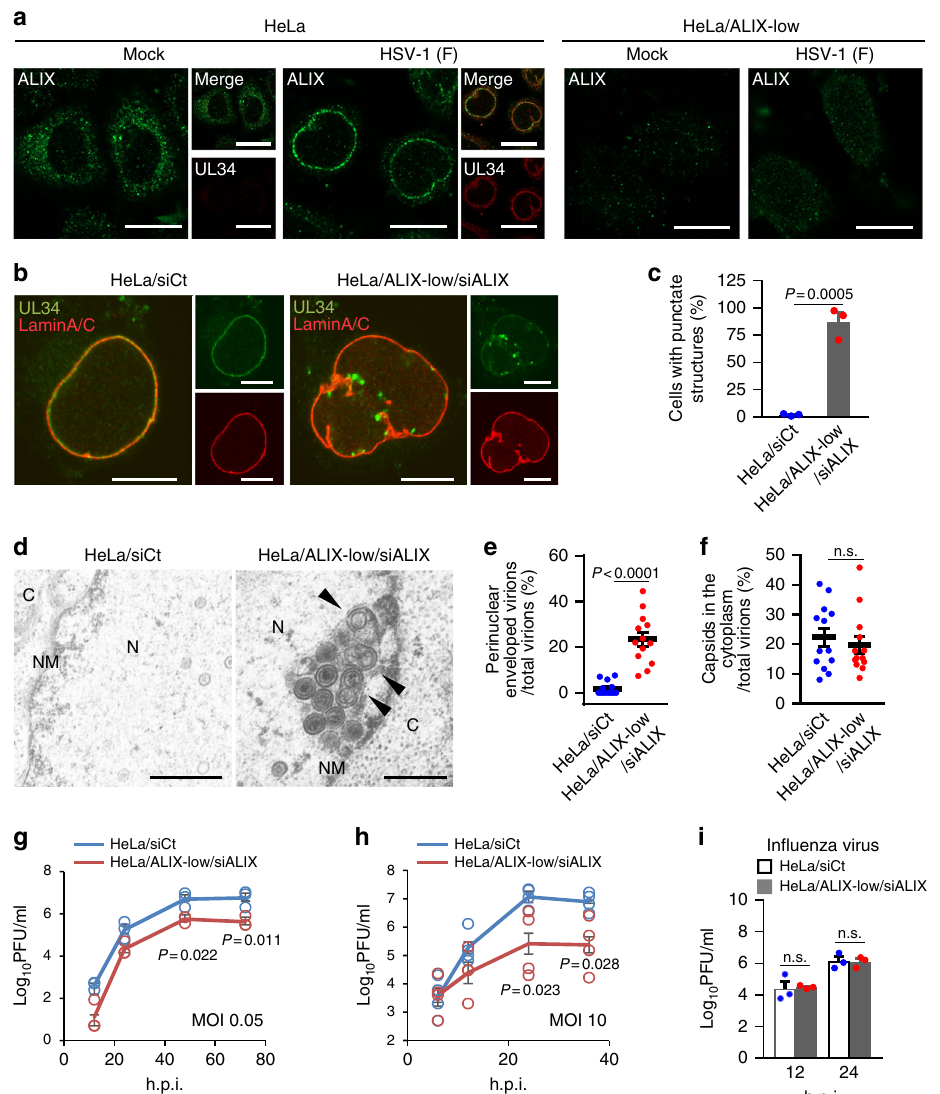
Fig. 4 ESCRT-III adaptor protein ALIX contributes to HSV-1 nuclear egress. a Confocal microscope images of HeLa or HeLa/ALIX-low cells mock-infected or infected with HSV-1 for 22 h and stained with anti-ALIX and anti-UL34 antibodies. Bars, 20 μ m. Images are representative of three independent experiments. b Confocal microscope images of HeLa and HeLa/ALIX-low cells treated with control siRNA (siCt) or siRNA to ALIX (siALIX), respectively, for 48 h, and then infected with HSV-1 for 22 h. Bars, 20 μ m. Images are representative of three independent experiments. c Percent of cells (50 – 100 cells in each experiment) with aberrant punctate structures along with the nuclear rim in the experiment in ( b ). Data are shown as the mean ± SEM of three independent experiments. d Electron microscope images of HeLa and HeLa/ALIX-low cells treated with siCt or siALIX, respectively, for 48 h and infected with HSV-1 for 22 h. C cytoplasm, N nucleus, NM nuclear membrane. Bars, 500 nm. Arrowheads indicate virions defective in the scission steps. Images